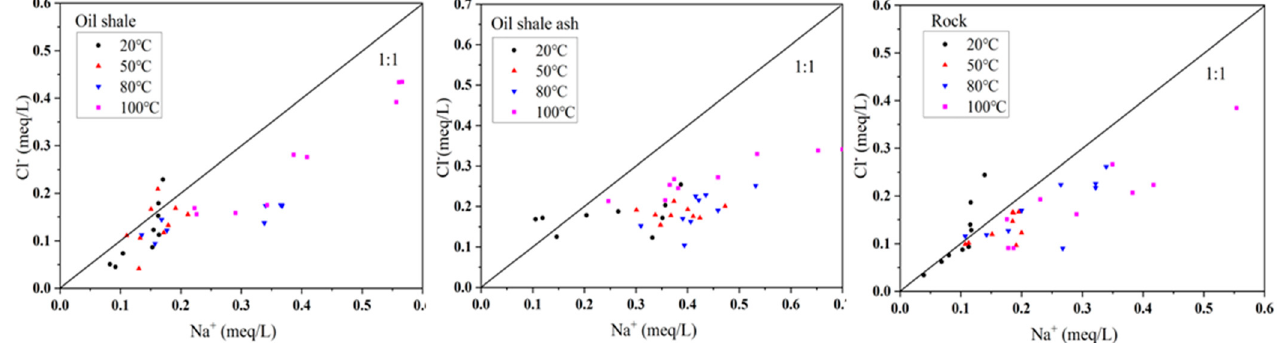
Figure 12. Scatter diagram of γ Na/ γ Cl in the aqueous solution under different reaction conditions.